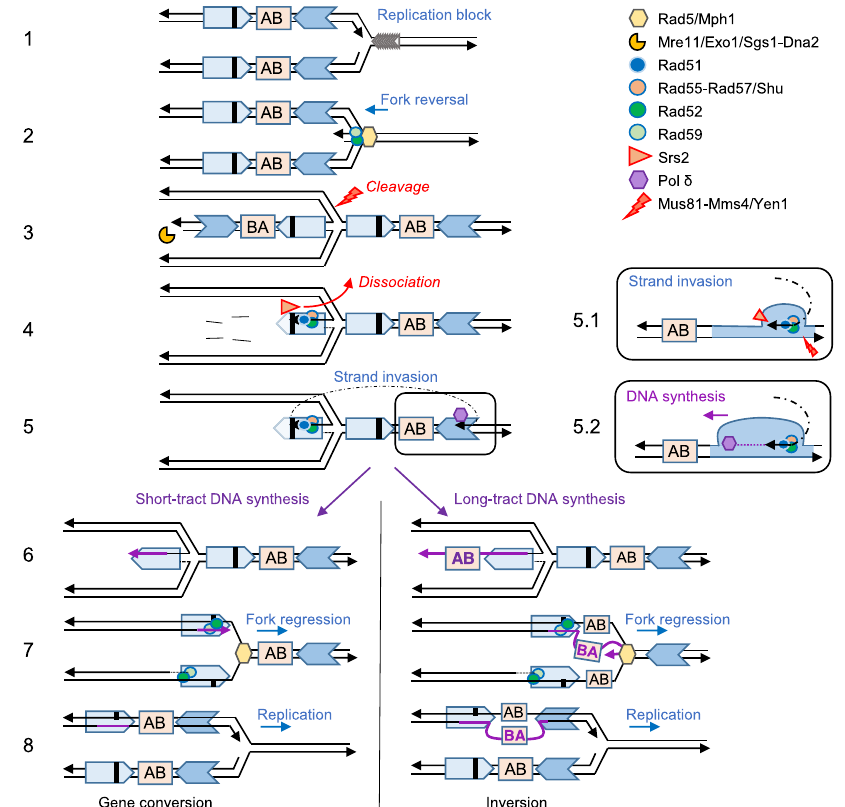
Fig. 5 Model for NAHR at arrested replication forks. (1) The replication fork stalls at the Tus/ Ter barrier. The letters AB indicate the orientation of the intervening sequence. The bold black line represents the + 2 frameshift. (2) Rad5 and Mph1 catalyze fork reversal. Rad52-Rad59 annealing activity could facilitate strand pairing of the daughter or parental strands. (3) The regressed arm is degraded by short and long-range resection machineries. The reversed fork can be cleaved by nucleases, aborting NAHR. (4) Rad51 polymerization on ssDNA is mediated by Rad52 and Rad55-Rad57 (with help from the Shu complex), counteracting the Srs2 anti-recombinase. (5) Rad51 catalyzes strand invasion into the parental non-allelic repeat, heterologies are cleaved by Rad1-Rad10 and DNA synthesis is initiated by Pol δ . The D-loop can be dissociated by Mph1 or Srs2, or cleaved by Mus81-Mms4 and Yen1. (5.1) Zoom on the structures proposed to form during strand invasion. (5.2) Zoom on DNA synthesis initiation. (6) Short-tract DNA synthesis leads to gene conversion, whereas long-tract DNA synthesis leads to the inversion of the intervening sequence (AB to BA) on the newly synthesized leading strand. (7) Regression of the reversed fork. (8) Replication restarts. Heteroduplex DNA incorporating the frameshift mutation could be corrected by mismatch repair to produce a gene conversion product or segregated at the next S phase. The large unpaired heterologous loop could be repaired by Rad1-Rad10 or segregated at the next replication